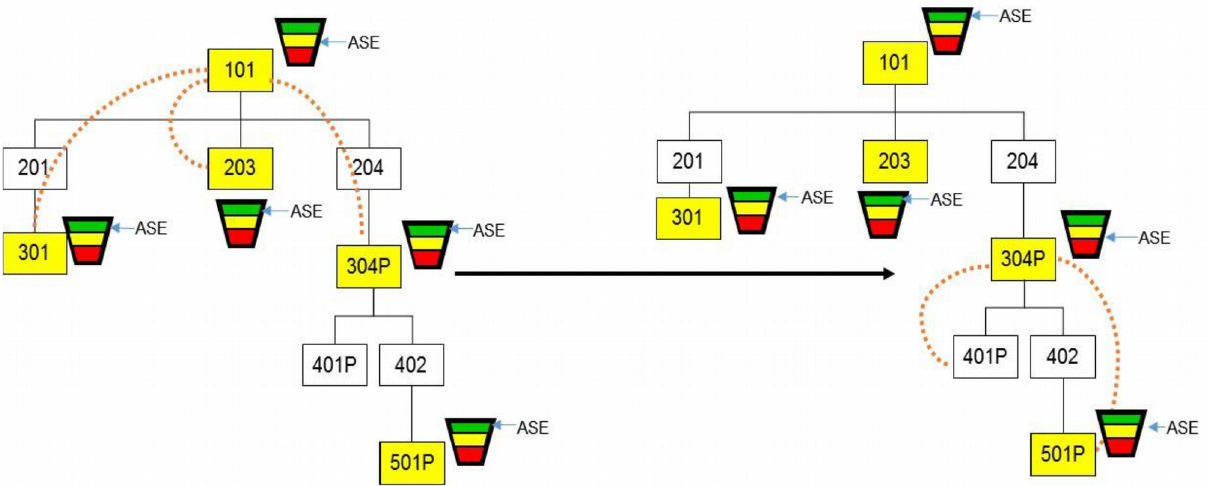
Figure 4. Decoupling explosion of the BOM (Ptak & Smith,